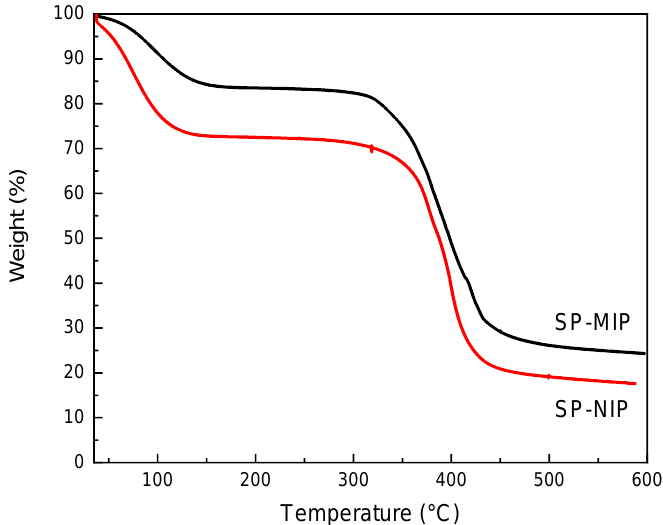
Figure 4. Thermogravimetric analysis (TGA) curves obtained for the superparamagnetic Imprinted polymer (SP-MIP) and superparamagnetic non-imprinted polymer SP-NIP.